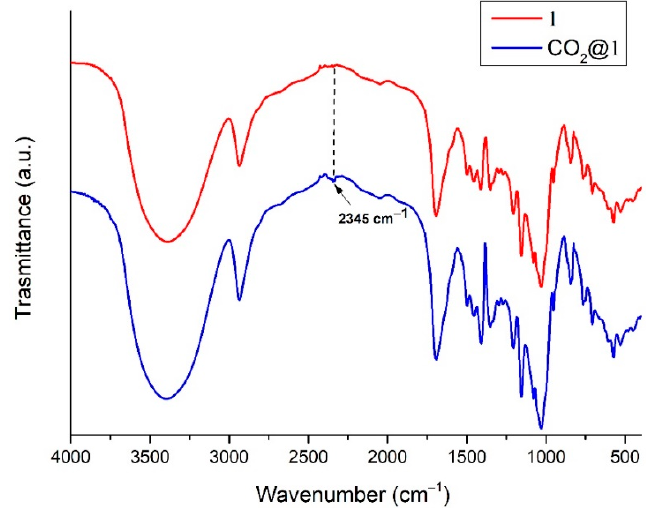
Figure 5. FTIR spectra of 1 before (red curve) and after (blue curve) CO 2 adsorption.